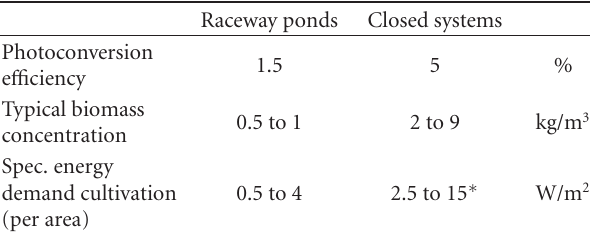
Table 6: Cultivation-system-related parameters (own estimates based on/completed with [9, 25,